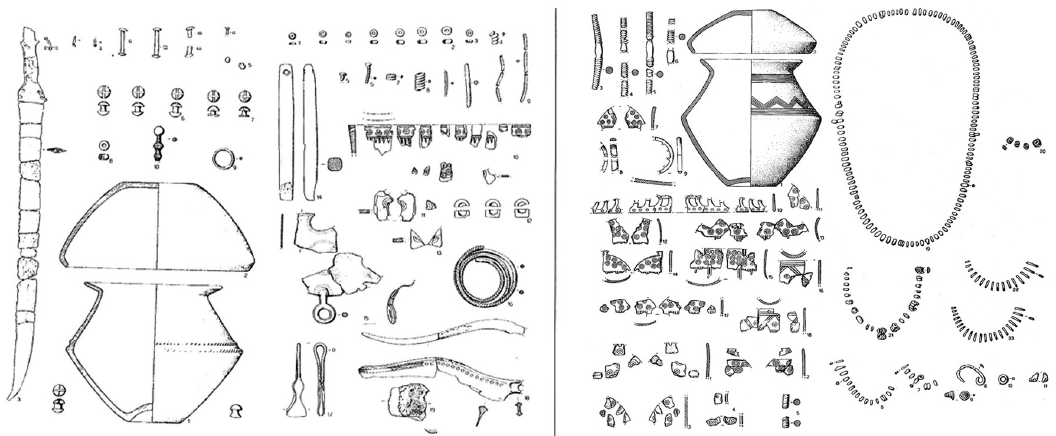
Fig 2. Clearly engendered grave good assemblages. Burials with typical masculine (left) and feminine grave goods (right) from Narde di Frattesina urnfield (mod. after [67]).